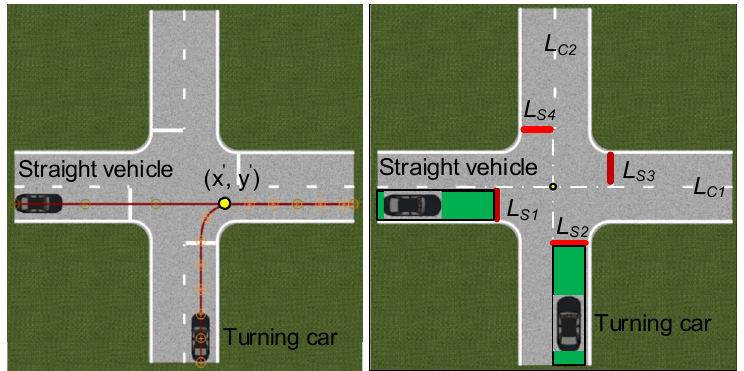
Figure 1. The relationship between two vehicles when passing through the intersection: ( a ) the possible driving directions of vehicle and ( b ) collision area under different conditions.